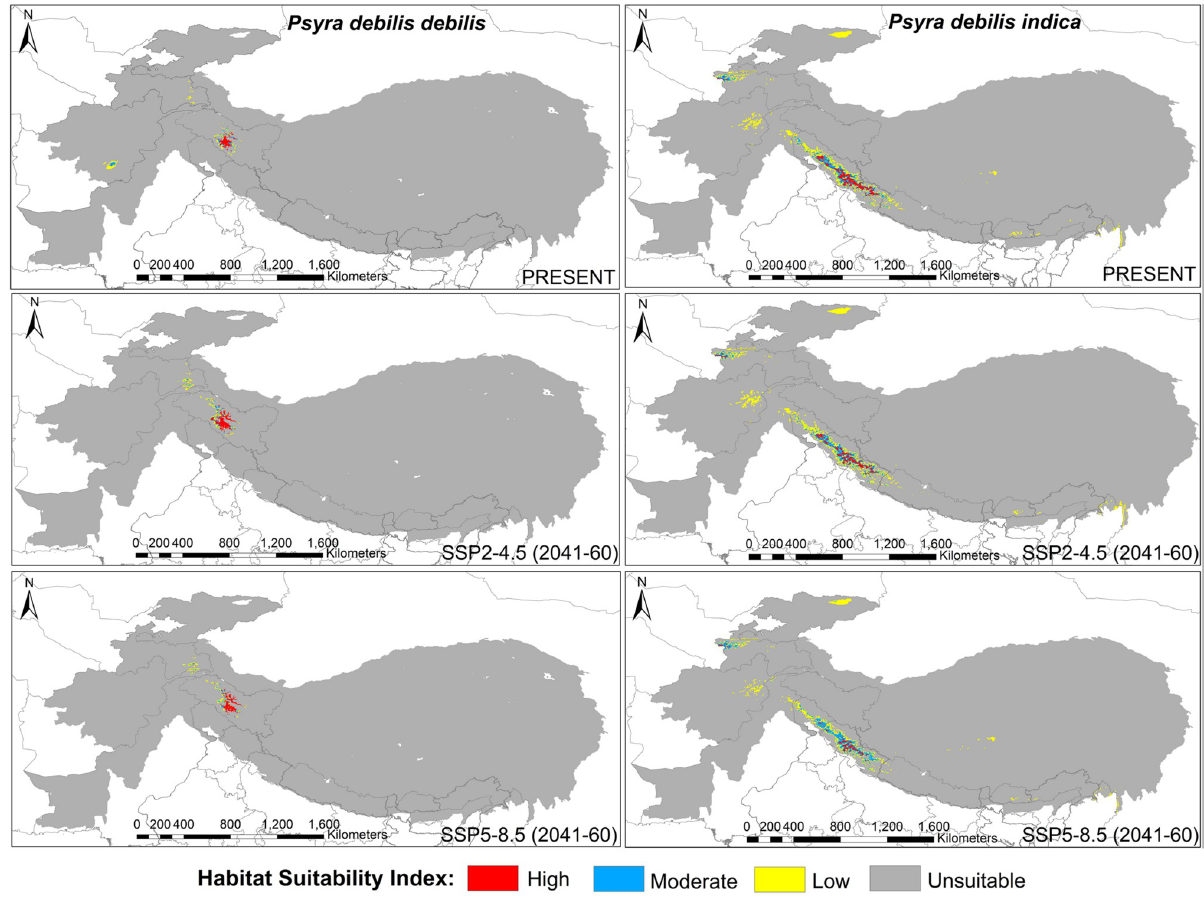
Fig 19. Predicted habitat suitability of Psyra debilis debilis & P . debilis indica under current (1970–2000) and two future climatic scenarios SSP2- 4.5 and SSP5-8.5 in the year 2041–60 based on MaxEnt species distribution model.